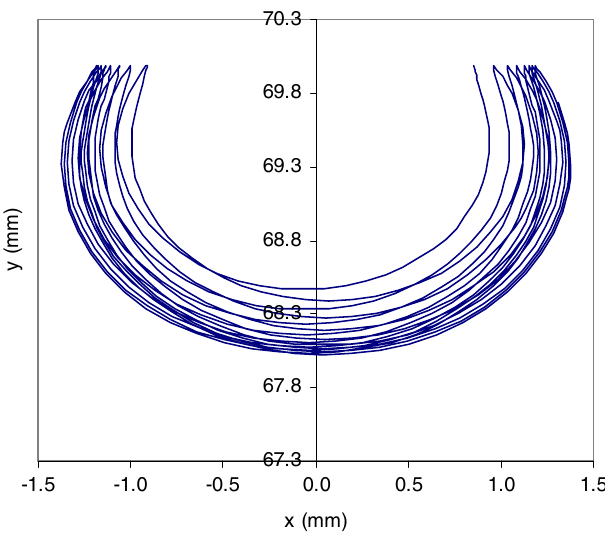
FIG. 7. Phase focusing of the electrons towards the resonant